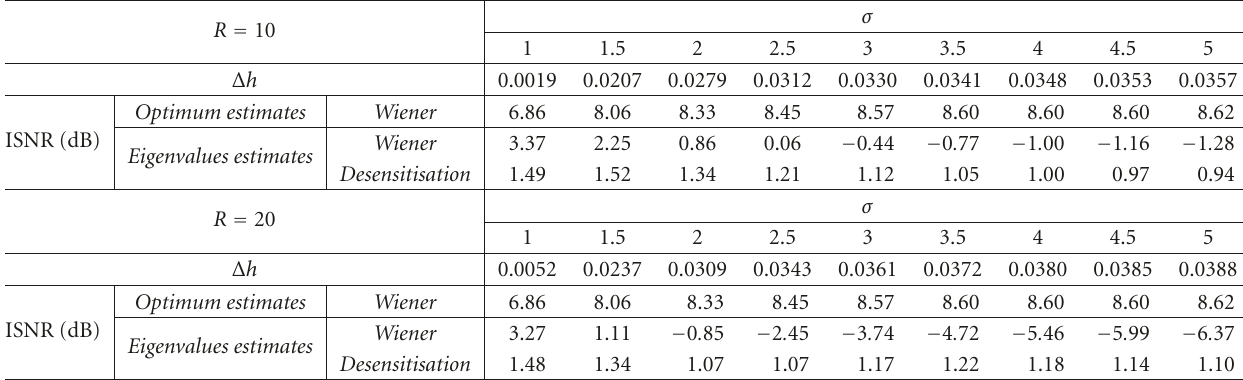
Table 3: Set of ISNR results obtained by both the Wiener filter and our proposed method when using estimates of a Gaussian 3 × 3 sized PSF computed by the algorithm of eigenvalues with di ff erent values for the standard deviation and specified to 10 and 20 eigenvectors R . Low-noise intensity is considered by a ratio of BSNR to 40 dB, keeping the estimated noise variance to the real value. The respective values of error Δ h per estimation of PSF are